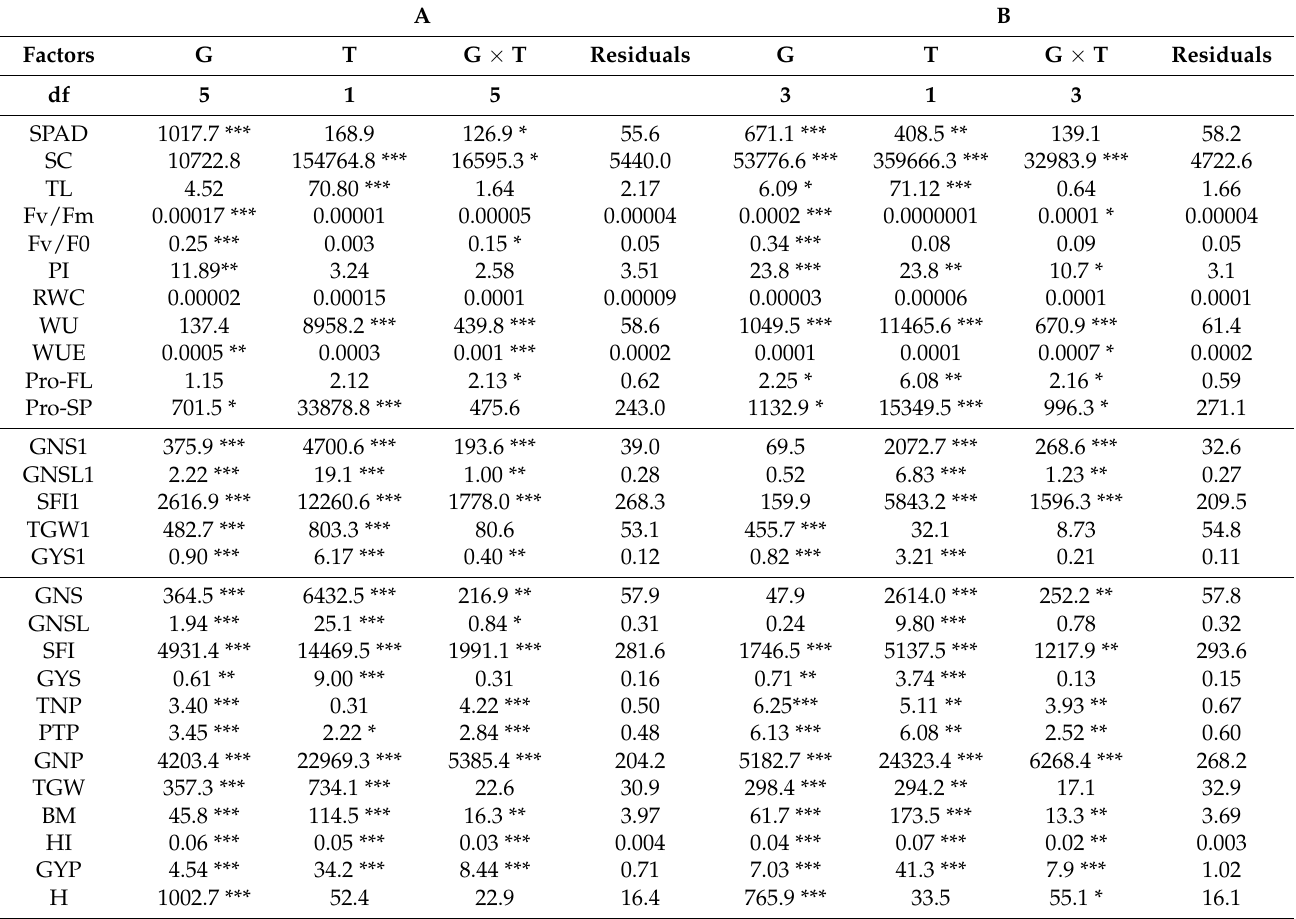
Table 3. ANOVA mean squares for physiological, biochemical and yield-related traits measured under control and combined water-deficit and 3-day HS (WH3): (A) comparison between alien segment carrier (+) and non-carrier ( − ) NIRLs, and (B) comparison between NIRLs+ and cv. Margherita. *, **, and *** indicate significance at p < 0.05, p < 0.01 and p < 0.001 levels, respectively. For trait acronyms, see the Materials and Methods